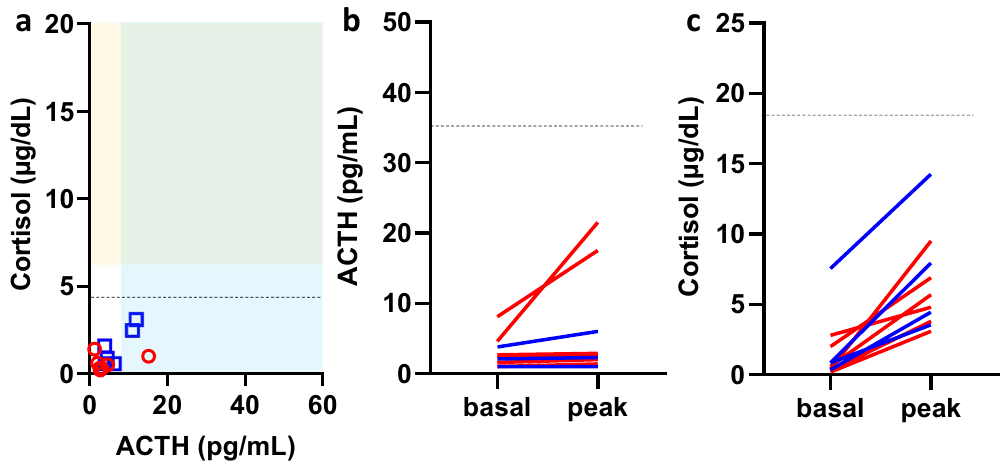
Figure 3. ACTH and cortisol levels upon the suspicion of secondary adrenal insufficiency (AI) and loading test results for the hypothalamus–pituitary–adrenal axis. (a) Casual plasma ACTH levels and serum cortisol levels on regular tests or upon the suspicion of a secondary AI are presented in the scatter plot. Open red circles reflect data of patients in the combination therapy group, and open blue squares reflect data of patients in the monotherapy group. The blue zone shows the reference interval for the plasma ACTH level in the morning (7.2–63.3 pg/mL), and the yellow zone shows the interval for the serum cortisol level in the morning (7.07– 19.6 μg/dL). Serum cortisol levels were all decreased to below 4.0 μg/dL (dotted line) without elevated plasma ACTH levels. (b) A corticotropin releasing hormone (CRH) test was conducted in which synthetic human CRH (100 μg) was intravenously injected and blood samples were collected before injection and at 30, 60, 90, and 120 min afterwards. The baseline and peak ACTH levels are shown. Red lines reflect results of patients in the combination therapy group, and blue lines reflect results of patient in the monotherapy group. The cut-off peak value of ACTH (35 pg/mL) is indicated by the dotted line. (c) A rapid ACTH test was performed in which synthetic ACTH (1–24) at 250 μg was intravenously injected. Blood samples were collected prior to the injection and at 30 and 60 min afterwards. The baseline and peak cortisol levels are shown. Red lines reflect results of patients in the combination therapy group, and blue lines reflect results of patient in the monotherapy group. The cut-off peak value of cortisol (18 μg/dL) is indicated by the dotted line.